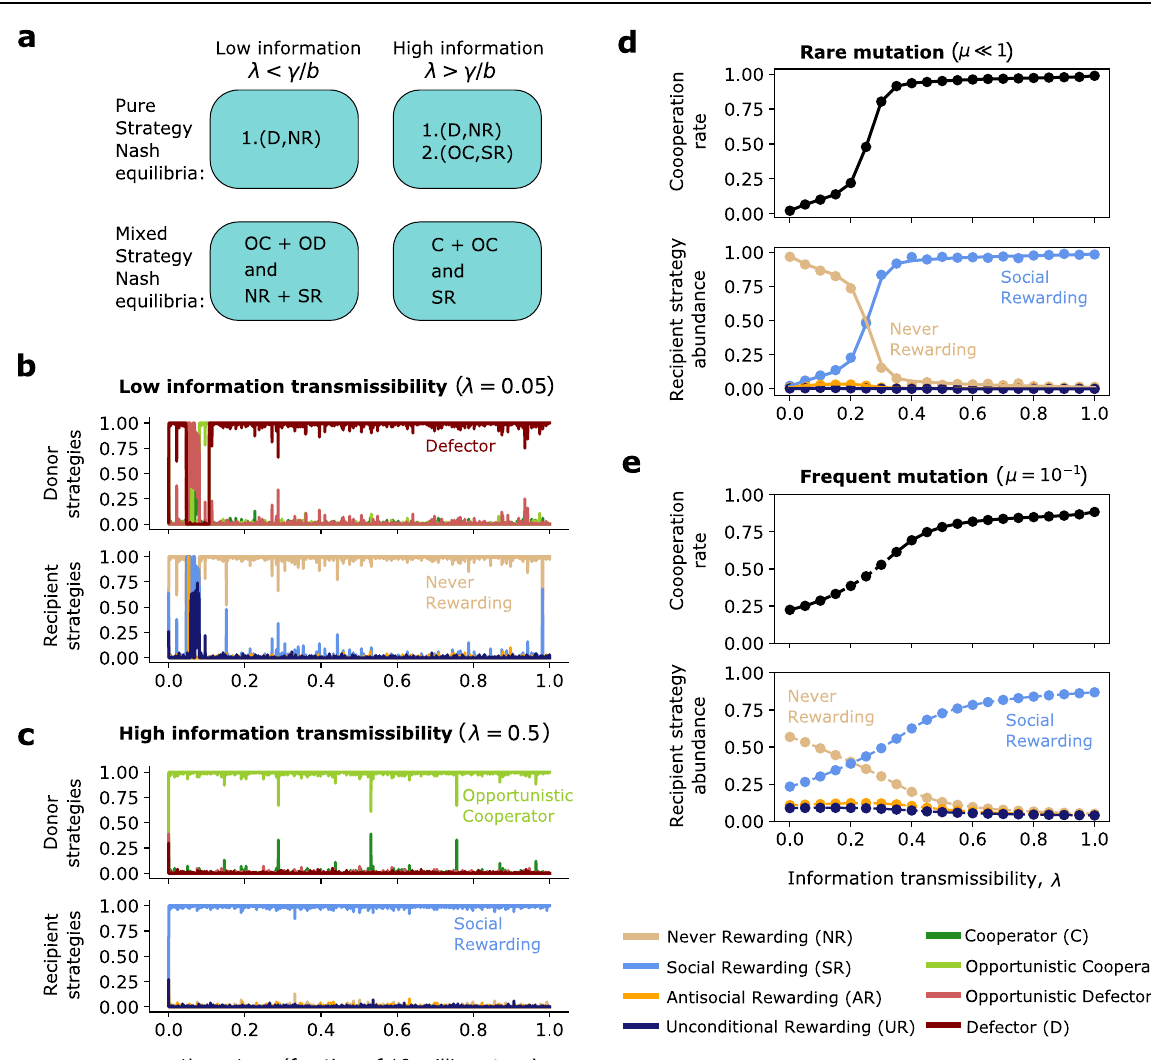
individuals cooperate opportunistically, and reward socially. d , e These qualitative results neither depend on the exact information transmissibility λ , nor on the mutation rate μ . Unless varied explicitly, we use the following default parameters for the simulations: Population size Z =100, strength of selection s =1, mutation rate μ =10 − 4 , and payoff parameters b =4, β =3, c = γ =1. The dots in